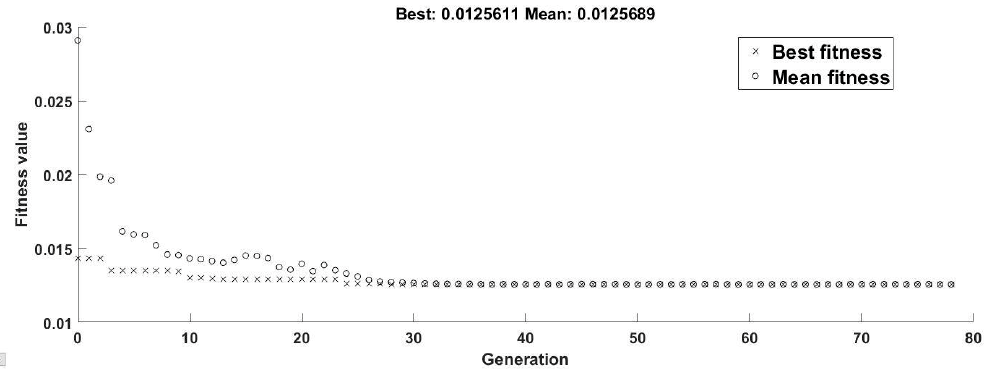
Figure 10. Convergence plot obtained by the GA for the GA–GRNN model through three-fold cross-validation.